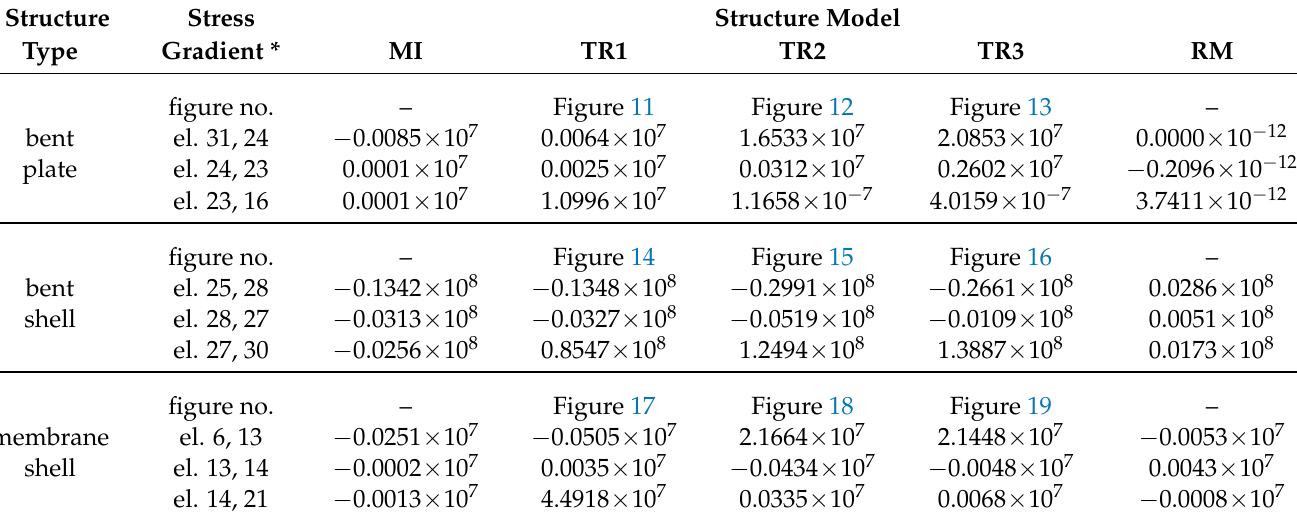
Table 1. Summary of stress gradients [N/m 2 ] for three model